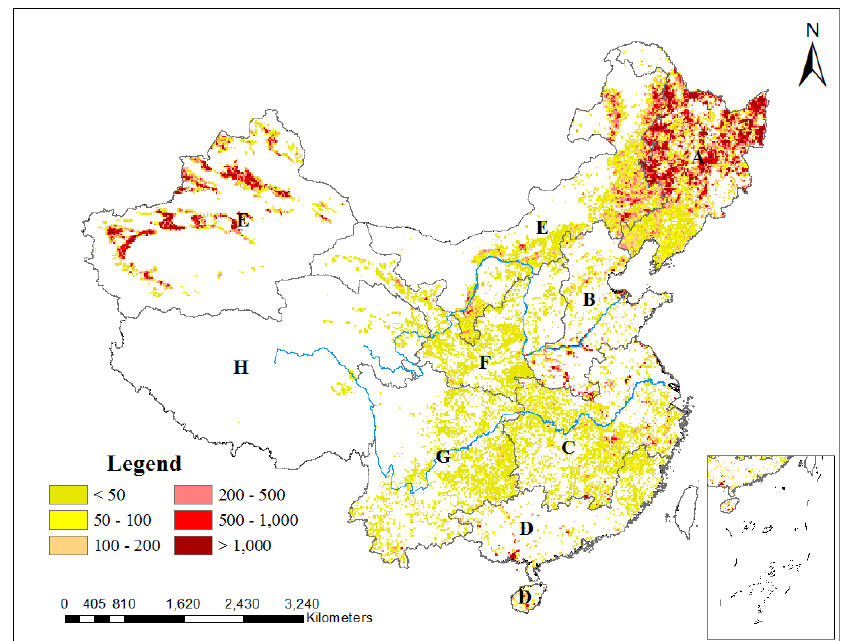
Figure 5. Increase in CR (t/10 km 2